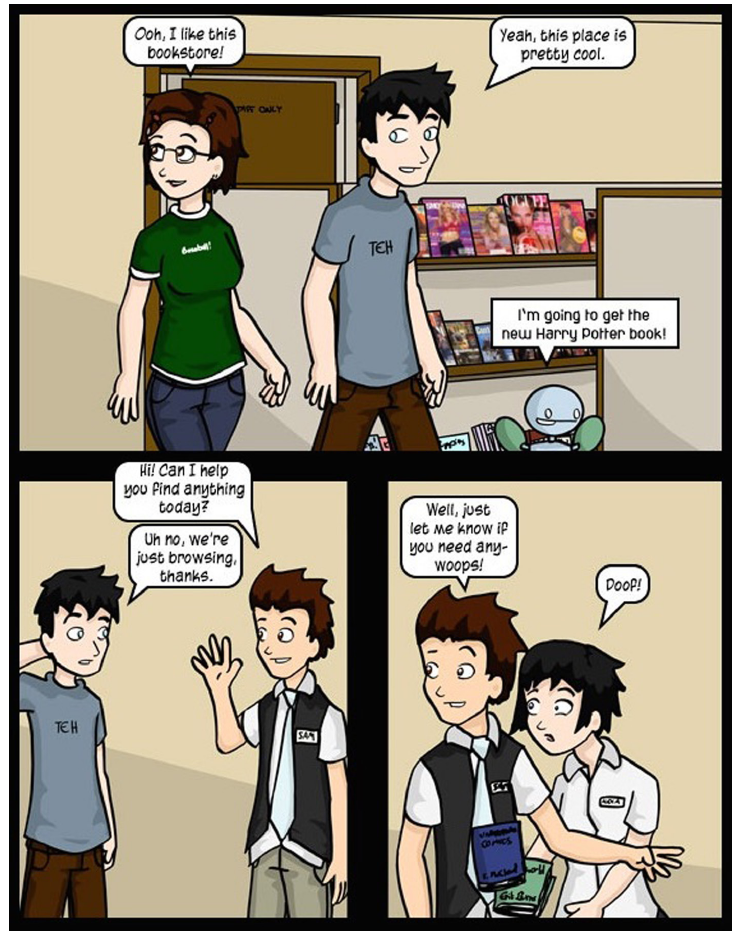
Figure 4: Jacques, J (2004) Guest: Jeph Jacques. On: Logan, S, Sam and Fuzzy . 11 November. Available at